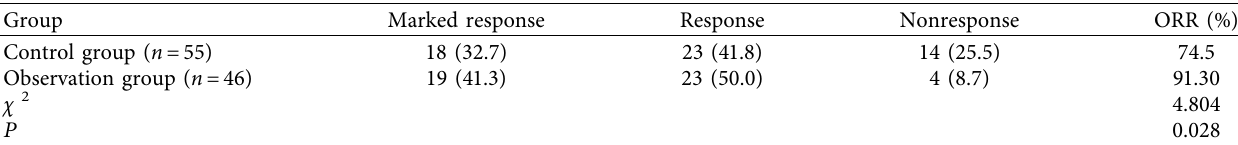
Figure 1: Comparison of operation conditions. (a) Comparison of operative time between the research group and control group; (b) comparison of intraoperative blood loss between the research group and control group and; (c) comparison of dental socket integrity scores between the research group and control group. Note. ∗ indicates that the difference between the two groups is statistically significant ( P < 0 . 05). Table 3: Comparison of clinical efficacy.